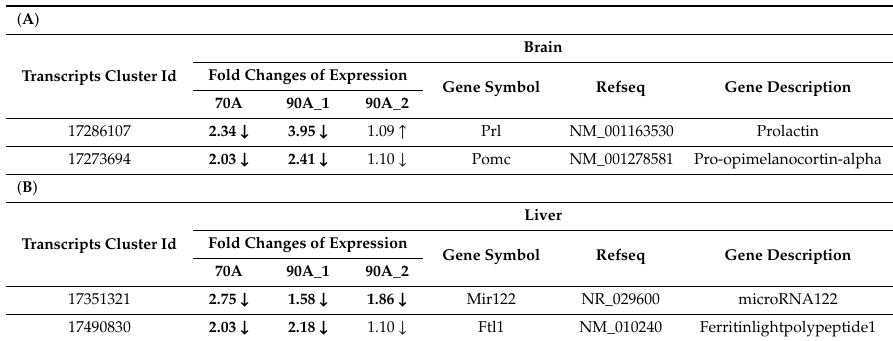
Table 2. Detected transcripts in the ( A ) brain and ( B ) liver with the following two limitations: the value of FC cuto ff of ≥ 2.0 in at least two out of three experiments (70A, 90A_1, and 90A_2 exposure) or the value of FC cuto ff of ≥ 1.5 in all three experiments after the non-FDR-adjusted approach.